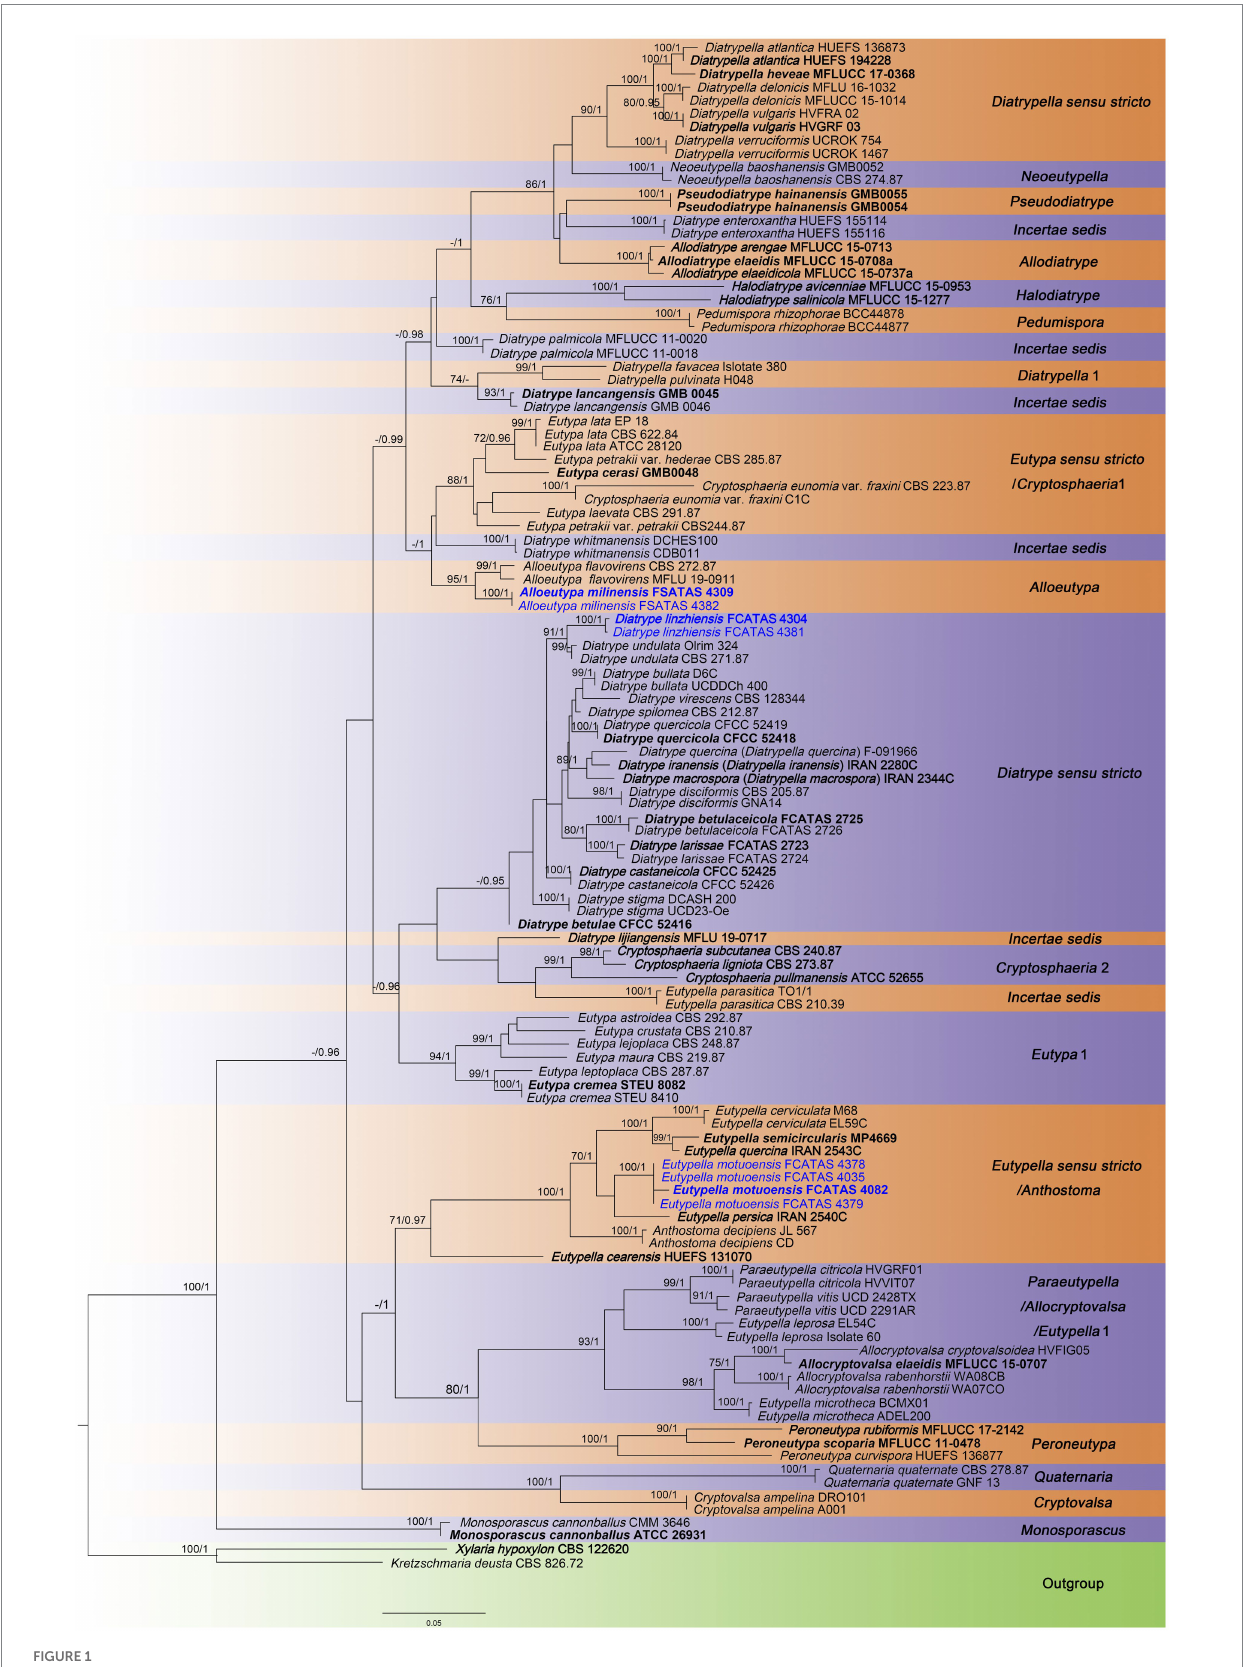
FIGURE 1 Phylogram generated from maximum likelihood (RA × ML) analyses, based on ITS- β -tubulin matrix. Branches are labeled with maximum likelihood bootstrap ≥ 70% and Bayesian posterior probabilities ≥ 0.95. Ex-type strains are in bold. Newly generated strains are in blue. Bold branches indicate that the length has been cut in